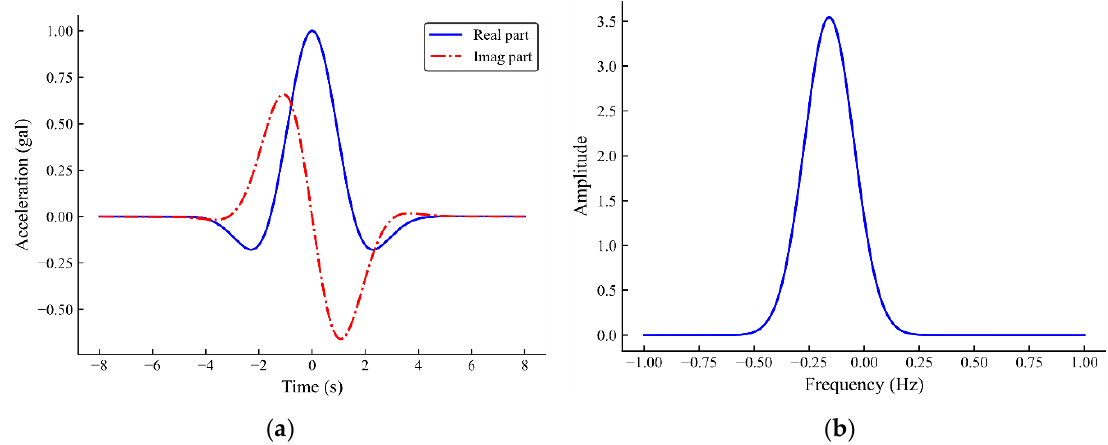
Figure 2. ( a ) Time and ( b ) frequency characteristics of Gabor wavelet basis.